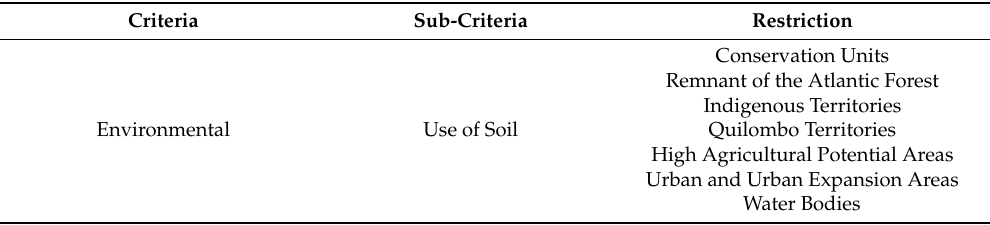
Table 4. Negative Indicators or